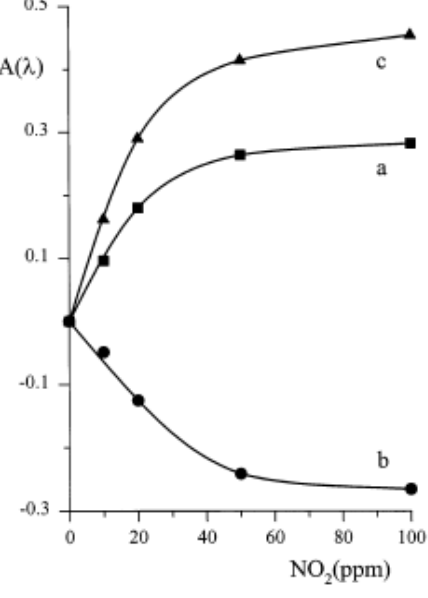
Figure 7. Absorbance versus concentration in correspondence with the three absorption peaks of the immobilised TiPc (curve a: λ 506 nm; curve b: λ 675 nm; curve c: λ 720 nm). 2 Reproduced with the permission from reference [39].